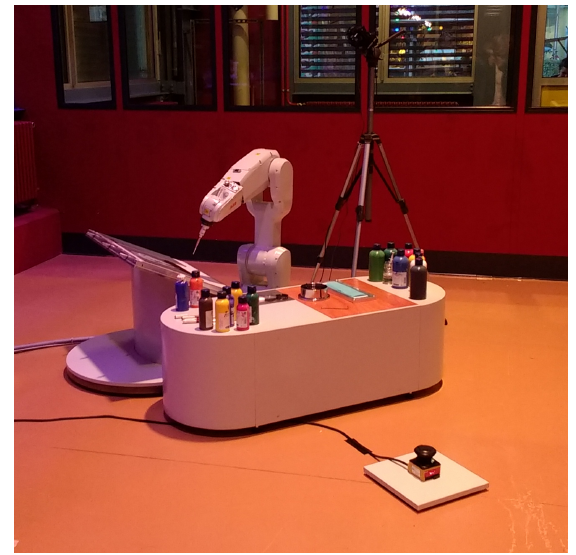
Figure 12. A mobile version of e-David being exhibited in